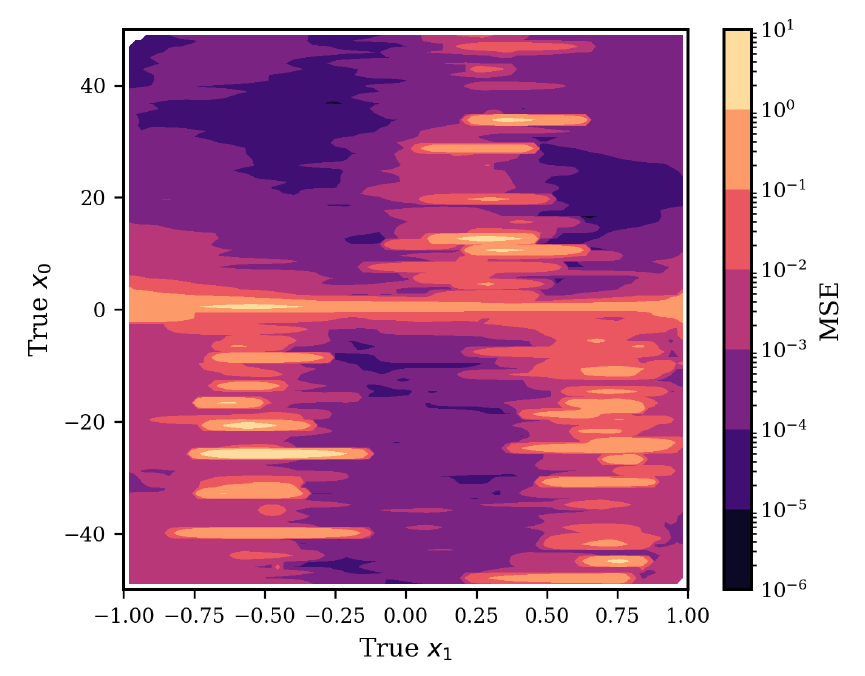
Figure 5: Heat map showing the MSE as a function of the true Stevens coefficients x and x for G = m¯3m and J = 4. The heat map shows a total number of 0 1 = 4 × 10 3 data points. Regions with larger MSE occur when x N testing comparable to the temperature probed ( x energy level crossing involving the ground state [ see Fig. 1(a) ] . While it becomes impossible to predict the coefficients if x creased MSE at the position of level crossings rather indicate an enhanced sensitivity of the observables with respect to small errors in the { ˆ x predicted by the network (see Fig.